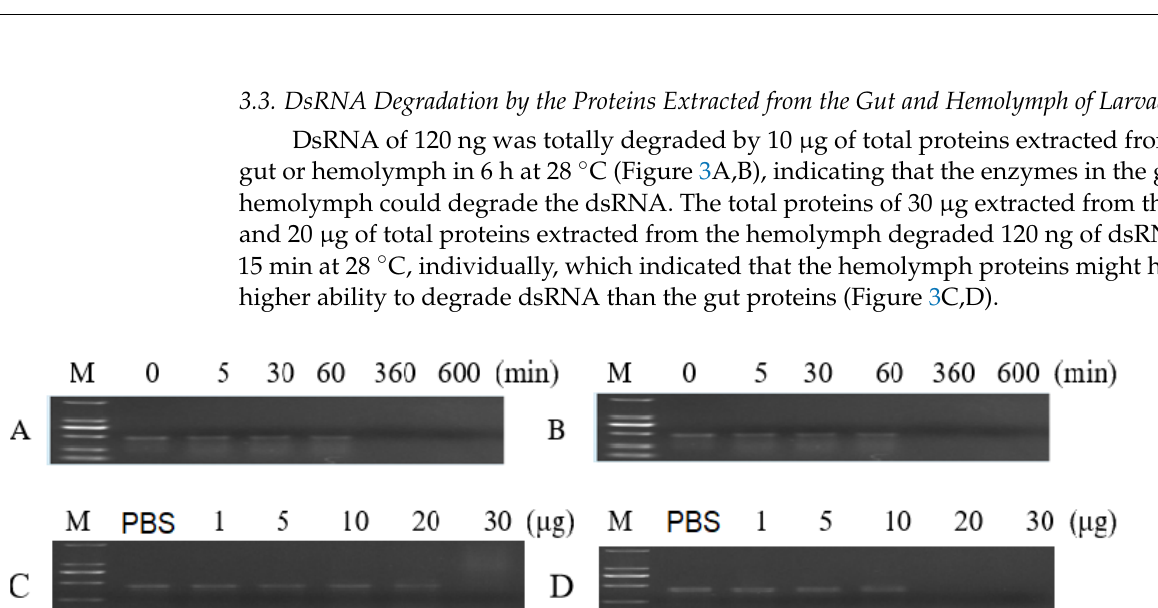
Figure 2. Relative expression levels of PxdsRNase genes. ( A ) Relative expression levels of PxdsRNase genes in different stages; ( B ) Relative expression levels of PxdsRNase genes in different tissues of the fourth instar larvae. EF1 was used as the reference gene. One-way ANOVA was conducted to cal- culate the statistical significance, followed by the Turkey test. Different letters on the bars represent significant differences ( p < 0.05) among different samples.